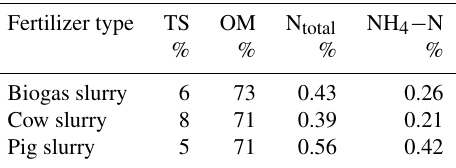
Table A2. Further information on the quantification rules to calcu- late the amount and type of mineral N from the reported applied mineral fertilizers on the 54 site years and the organic matter con- tent.